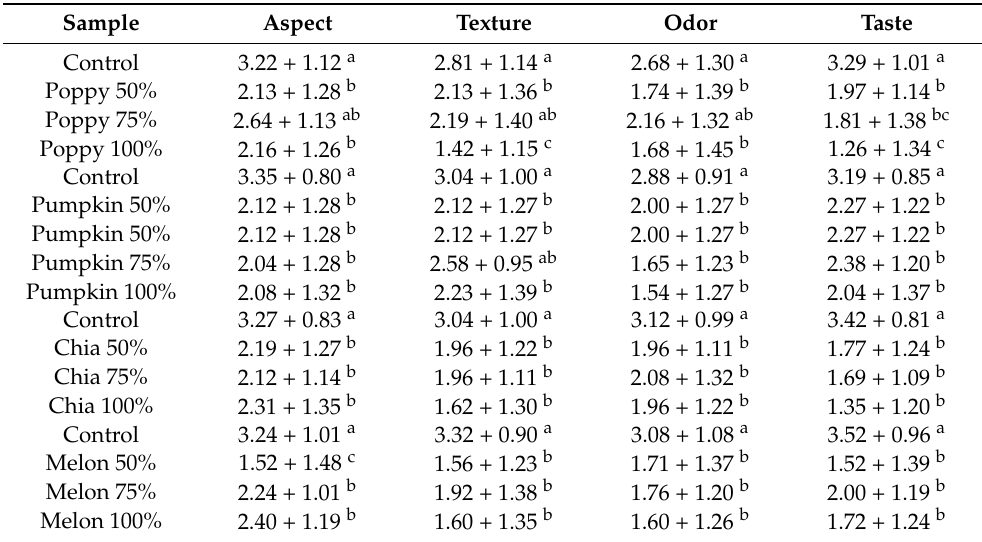
Numbers are means with standard errors. Different letters in the same column for each attribute indicate statistically significant differences ( p <